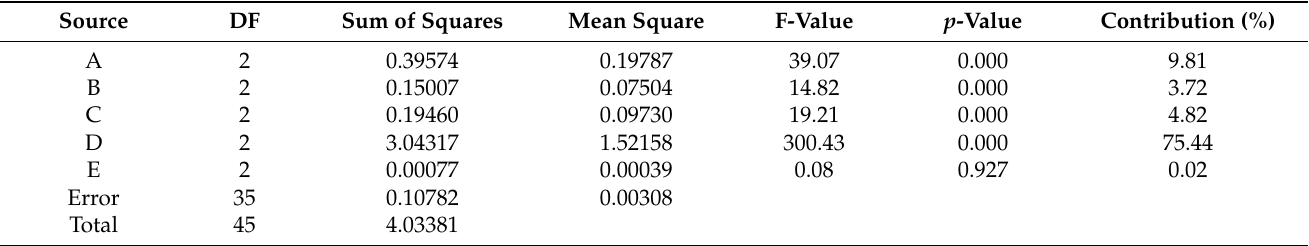
Table 12. ANOVA for root circle diameter